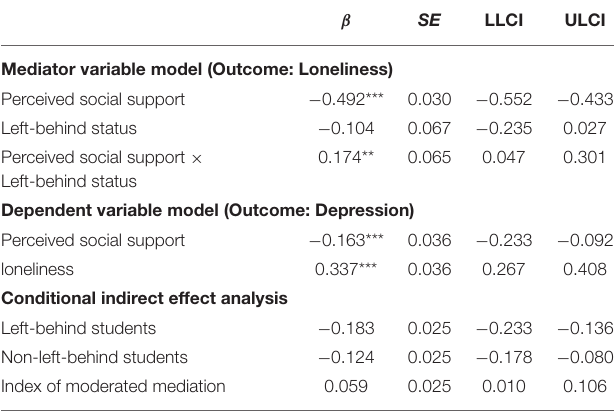
TABLE 5 | Testing the moderated mediation effect ( N = 826).